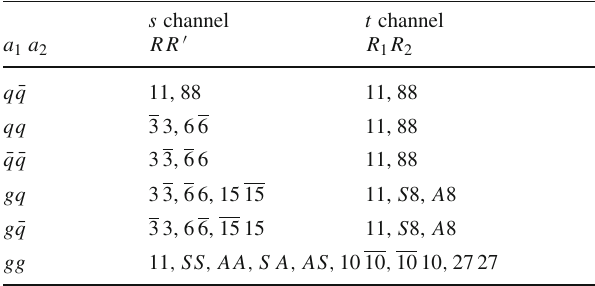
Table 1 Combinations of colour representations in the s channel dis- tributions F RR (cid:3) two-gluon distributions, the colour combinations are identical in the s and t channels.Interchanging a 1 ↔ a 2 impliesinterchanging R 1 ↔ R 2 while keeping RR (cid:3)